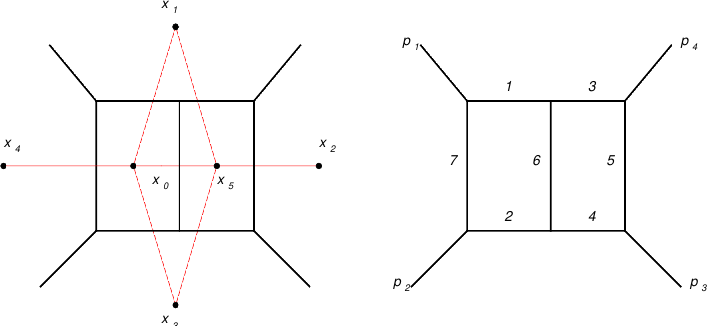
Figure 3 . Double box integral in the dual and standard variables. The numbers on the propagators numerate the corresponding alpha